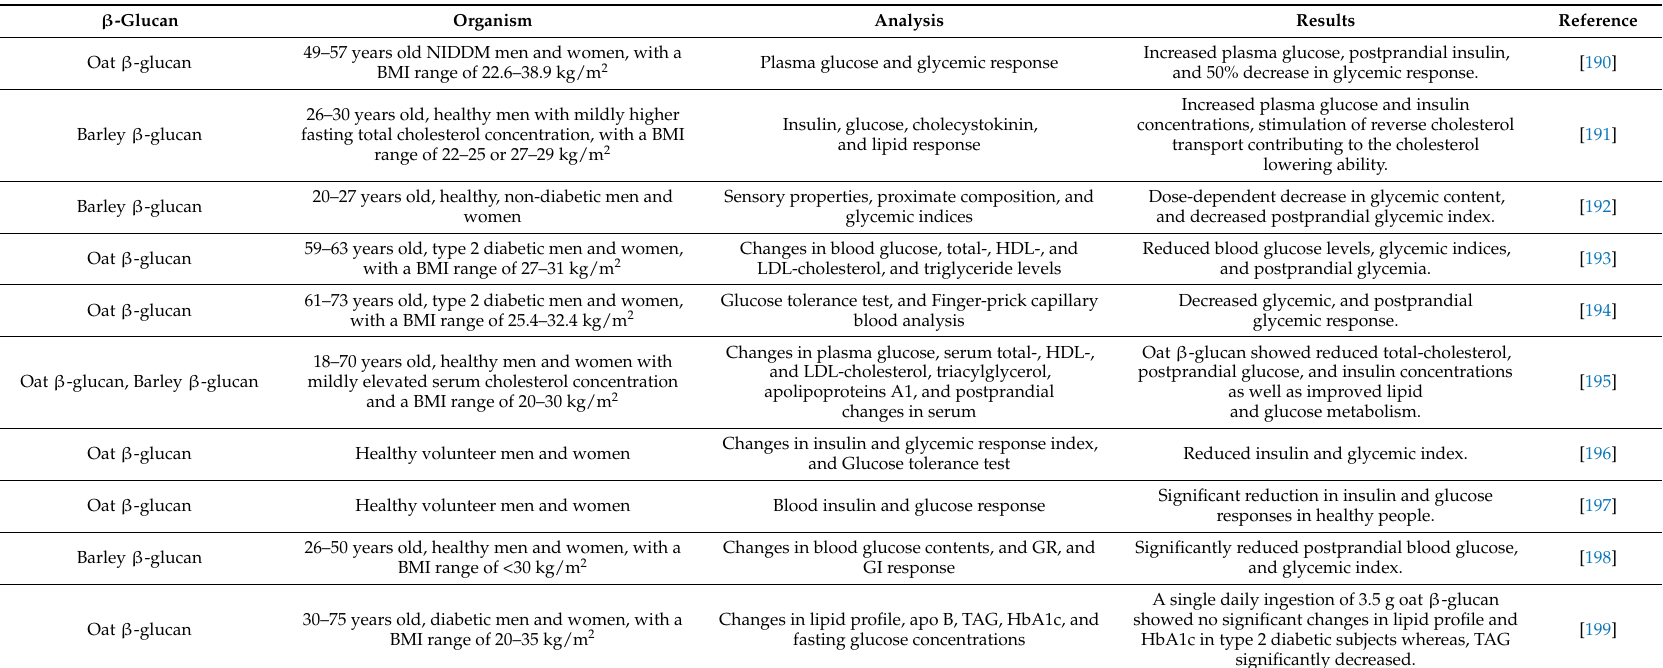
Table 12. Anti-diabetic/anti-obesity effects of β -glucans—human